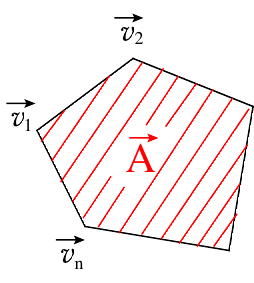
Figure 1 . A point ~A inside a polytope is given by a non-negative sum of the vertices ~v i . The unitarity constraint (2.5) demands the four-point function vector F to lie in the positive span of the block vectors G (cid:1)